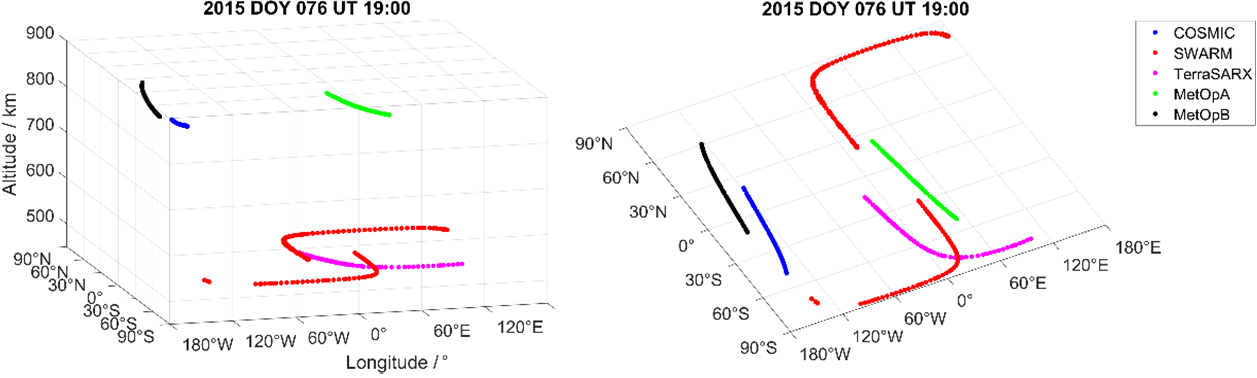
Figure 6. The locations of the LEO satellites for the STEC measurements used in the reconstruction.